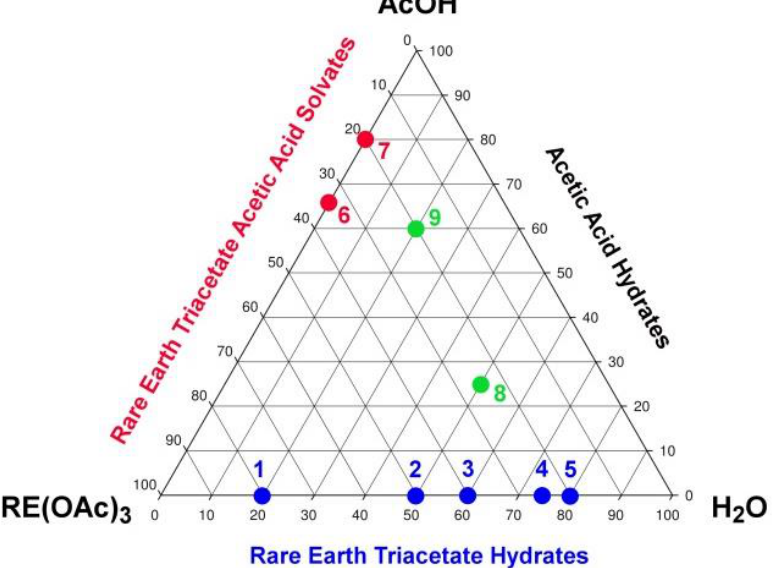
Figure 1. Gibbs triangle on the structurally well documented classes of compounds in the three phase system RE(OAc) 3 , H 2 O and AcOH. Hydrates : RE(OAc) 3 · n H 2 O: RE(OAc) 3 · ½ H 2 O, 1 , (RE = Nd [5], Gd [6], Tb [7], Dy [8], Ho [9], Er [5] ); α -RE(OAc) 3 · H 2 O, 2 , (RE = Ce [10,11], Pr [12,13] ); β -RE(OAc) 3 · H 2 O, 2 , (RE = Nd [10,13]); RE(OAc) 3 · 1½ H 2 O, 3 , (RE = Ce [10], Pr [14]); RE(OAc) 3 · 3H 2 O, 4 , (RE = Eu [12,15], Gd [16]); RE(OAc) 3 · 4H 2 O, 5 , (RE = Nd [17] without coordinates, Sm [10,18,19], Eu [18], Gd [19–22], Tb [23], Dy [24,25], Ho [26], Er [27,28], Tm [29], Yb [30], Lu [10]); Acetic acid solvates : RE(OAc) 3 · 2AcOH, 6 , (RE = Nd, Sm [5]); RE(OAc) 3 · 4AcOH, 7 , (RE = Pr, Nd [5]); Acetic acid solvate hydrates : RE(OAc) 3 · AcOH · 2H 2 O, 8 , (RE = Sm [31], Eu [10]); α -RE(OAC) 3 · 3AcOH · H 2 O, 9